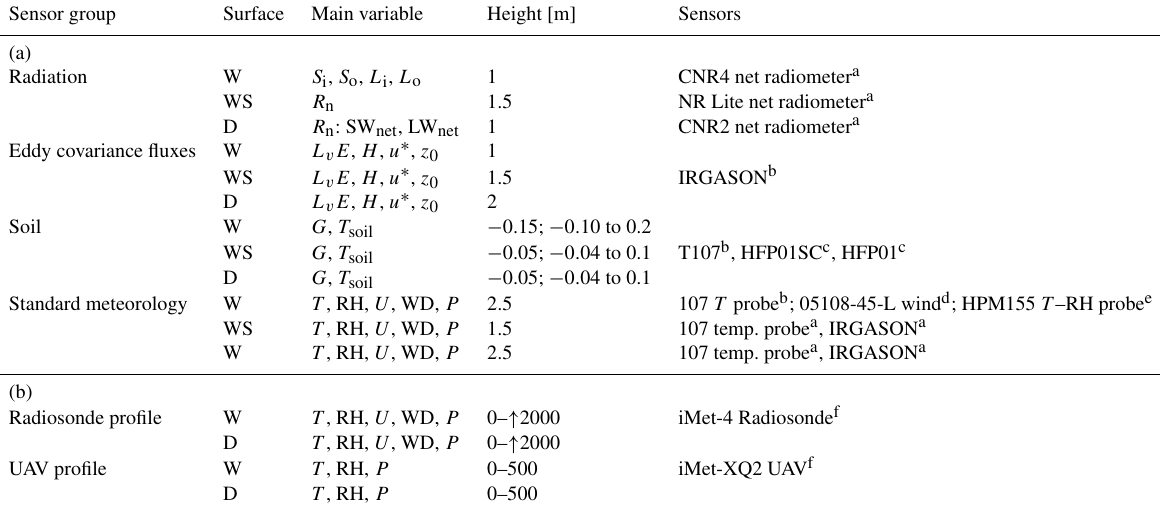
Table 1. Main variables and sensors utilized during the E-DATA experiment, by sensor group and surfaces: water (W), wet salt (WS) and desert (D). (a) Surface main variables: incoming shortwave radiation ( S i ), outgoing shortwave radiation ( S o ), incoming longwave radiation ( L i ) and outgoing longwave radiation ( L o ), shortwave net radiation (SW net ), longwave net radiation (LW net ), net radiation ( R n ), latent heat flux ( L v E ), sensible heat flux ( H ), friction velocity ( u ∗ ), ground heat flux ( G ), soil temperature ( T soil ), air temperature ( T ), relative humidity (RH), wind speed ( U ), wind direction (WD), and pressure ( P ). (b) Vertical main